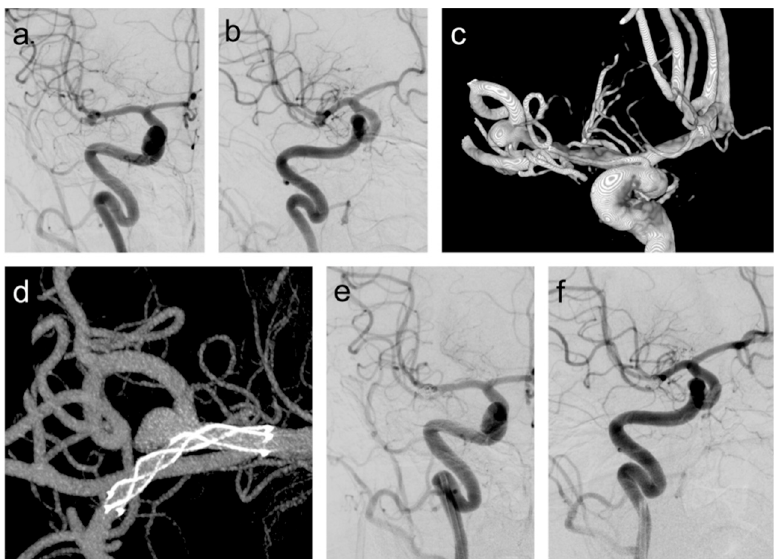
Figure 1. ( a , b ) A patient with a wide-necked right middle cerebral artery (MCA) bifurcation aneurysm. The aneurysm was treated with the stent-assisted coiling using the low-profile visualized intraluminal support junior (LVIS Jr.); ( c ) three-dimensional reconstruction demonstrates the complex morphology of the aneurysm; ( d ) intraprocedural contrast-enhanced flat panel detector computed tomography (CT) (maximum intensity projection (MIP) reconstruction) showing full stent opening with wall adherence along the length of the device; ( e , f ) Post-procedural digital subtraction angiography (DSA)